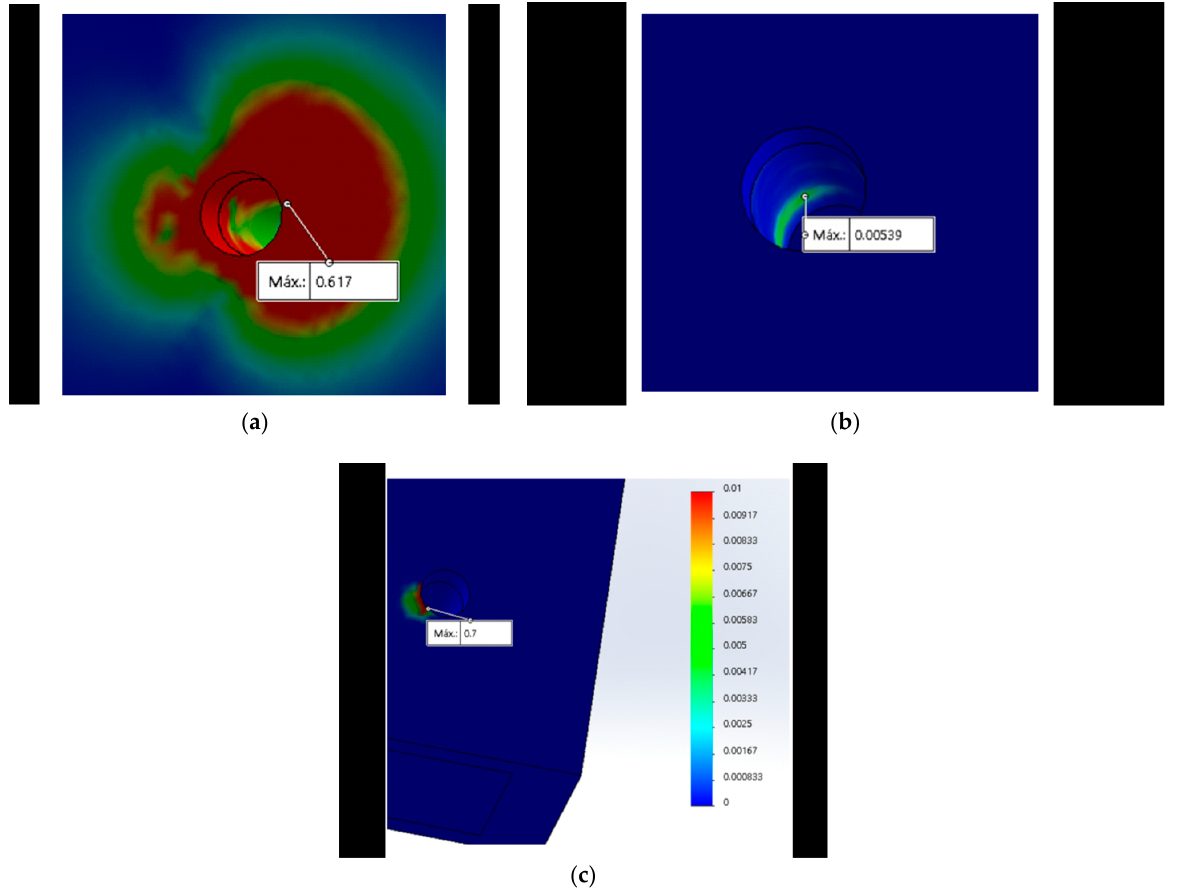
Figure 6. Maximum stress with 350 N in the bone is represented by the red color using the von Mises scale: ( a ) Maximum stress at the neck in the IH connection; ( b ) maximum stress at the middle in the MT connection; ( c ) maximum stress at the neck in the TC connection.